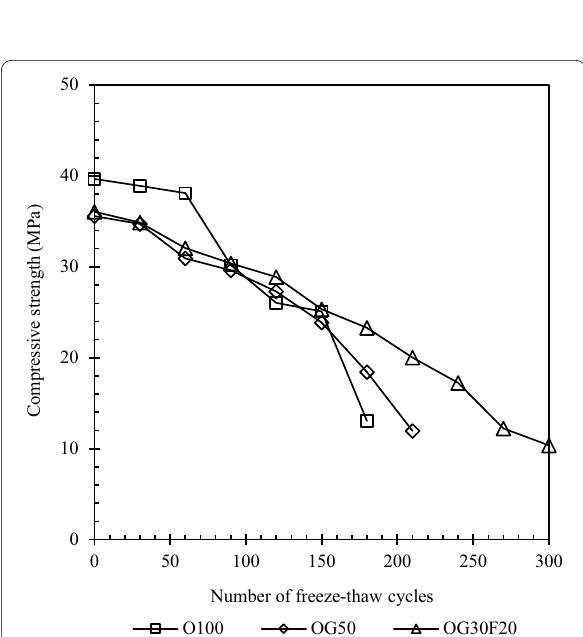
Fig. 6 Compressive strength of concrete subjected to freeze–thaw